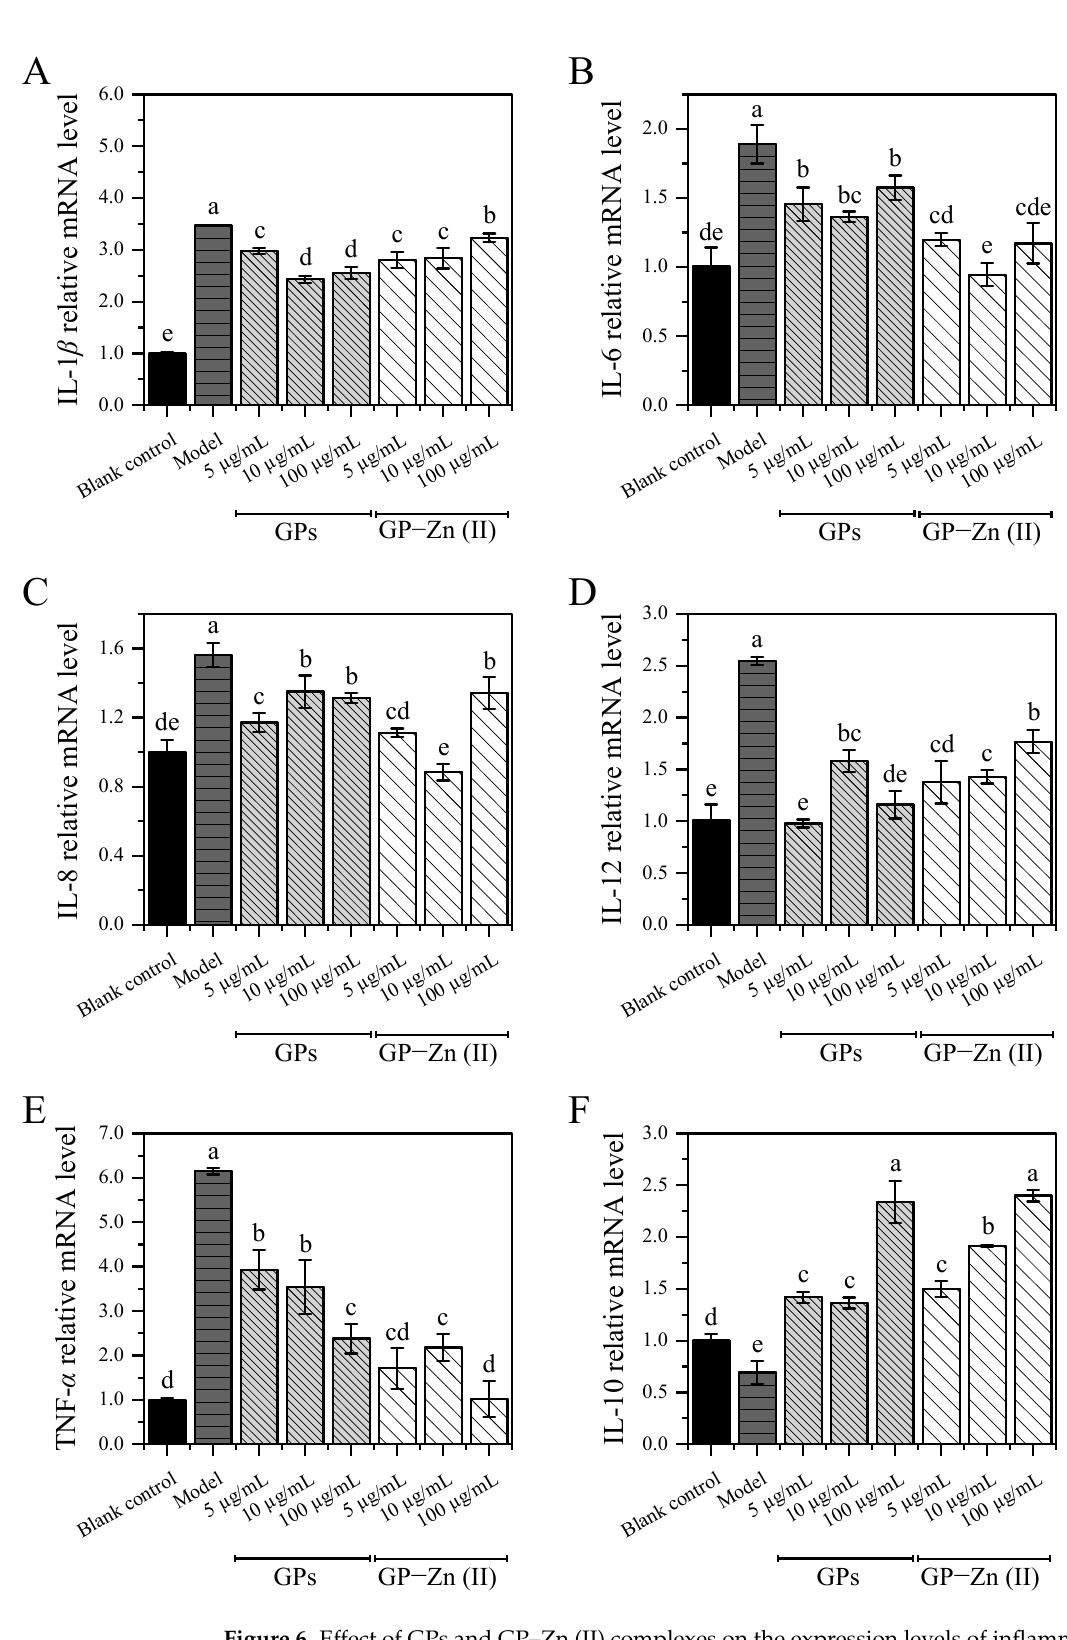
Figure 6. Effect of GPs and GP–Zn (II) complexes on the expression levels of inflammation-related cytokines in zebrafish. ( A ) IL-1 β ; ( B ) IL-6; ( C ) IL-8; ( D ) IL-12; ( E ) TNF- α ; ( F ) IL-10. Data are presented as mean ± standard deviation. Different letters (a, b, c, d and e) indicate significant differences between the expression levels of inflammatory cytokines ( p <